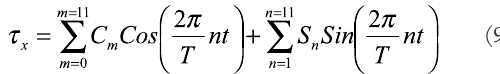
Table 1. List of ionosonde stations used for ionospheric slab thickness model